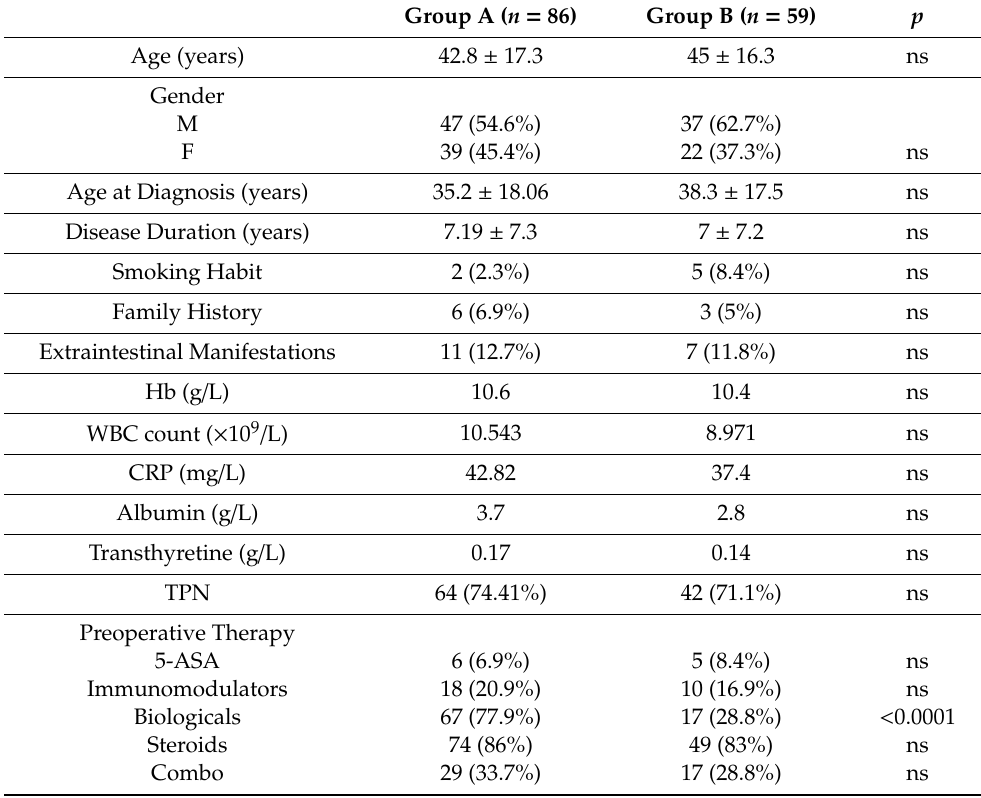
Table 1. Patients characteristics.